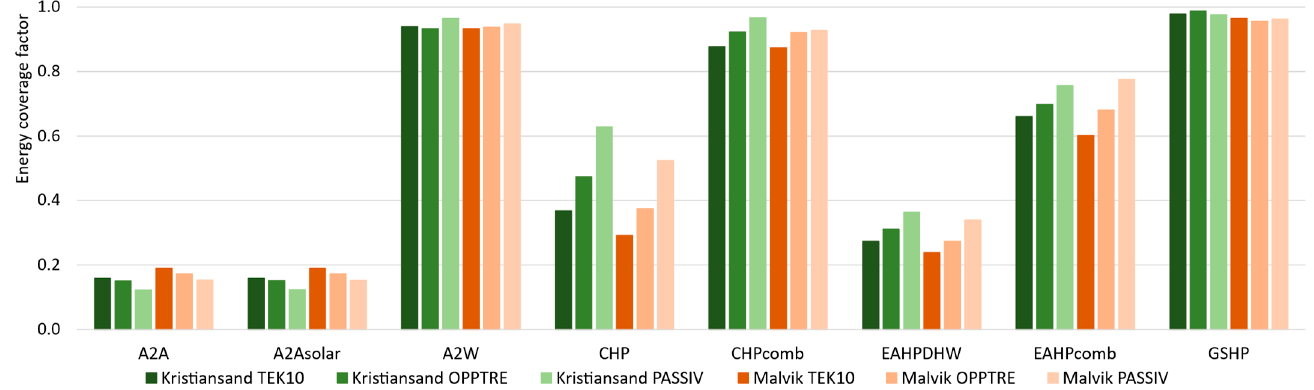
Figure 4. Energy coverage factor of the heat pump systems in both houses.